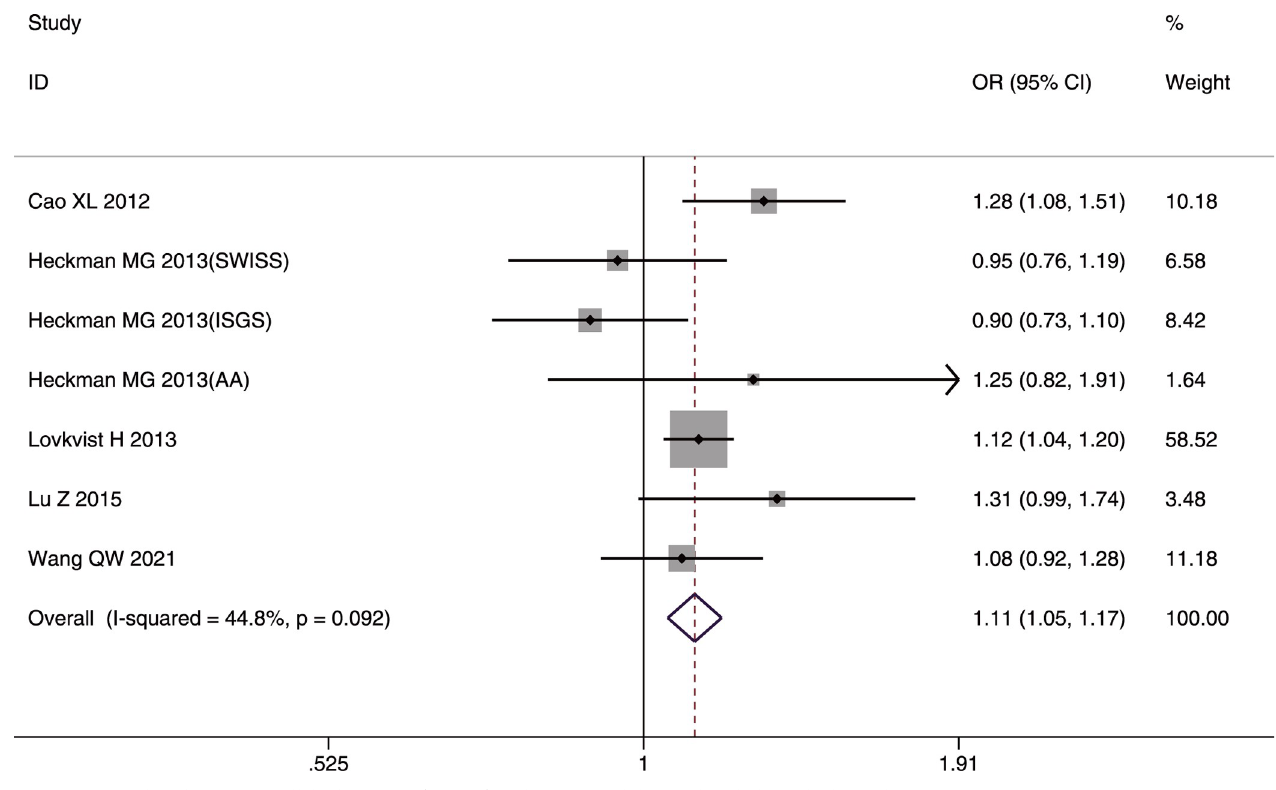
Fig 12. Forest plot of rs4977574 allelic frequency (G vs. A) and IS susceptibility in the whole studied population.